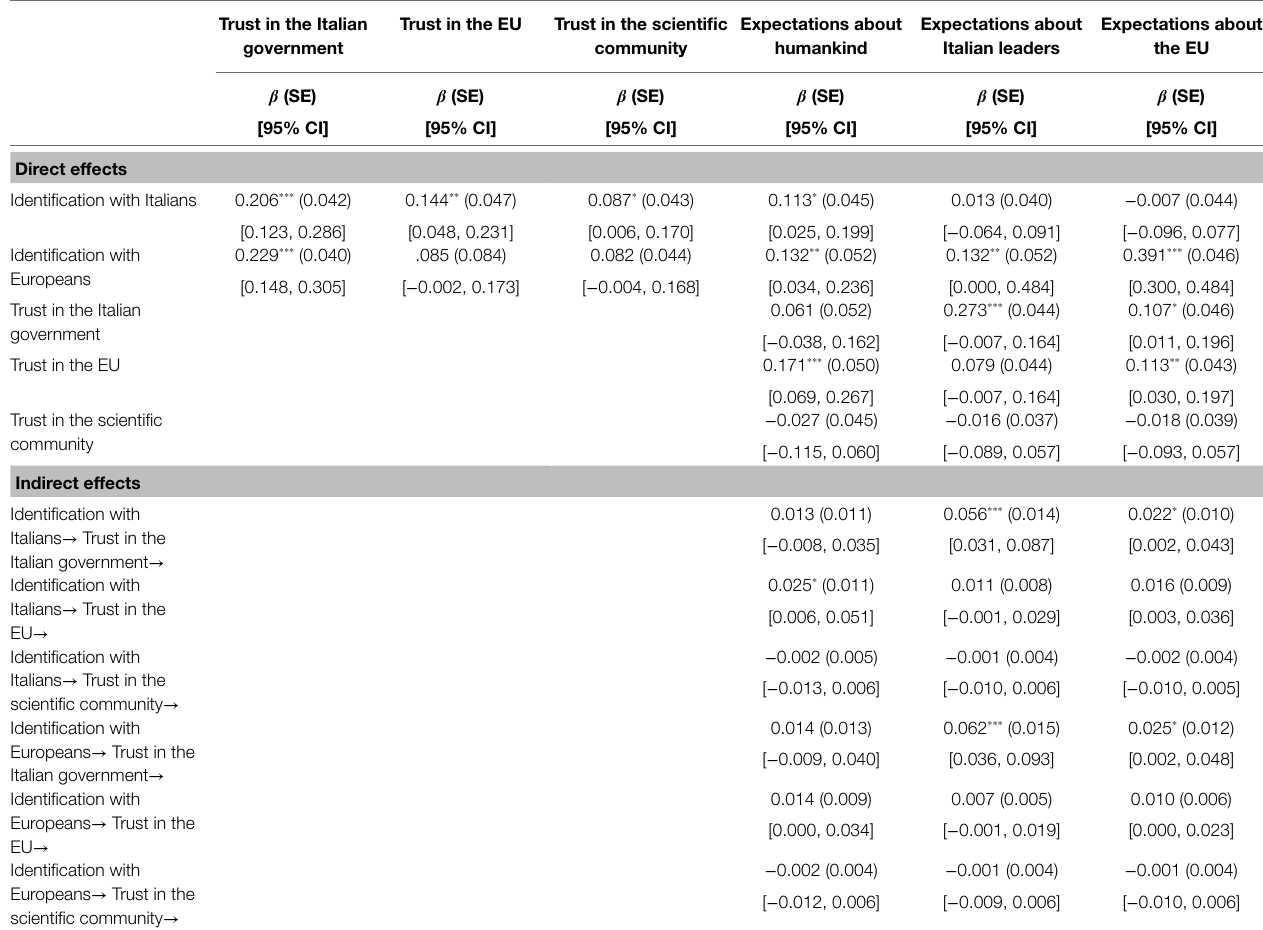
TABLE 3 | Standardized Direct and Indirect